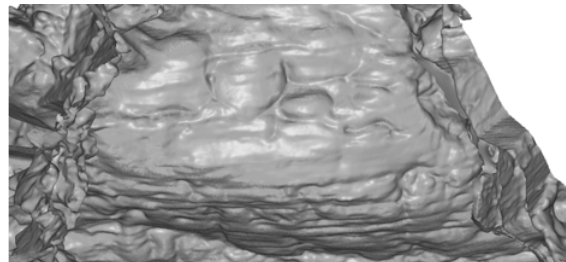
Figure 8. Orthophotos processed from the shaded 3D model enhancing the relief understanding (see the photo in Figure 3)